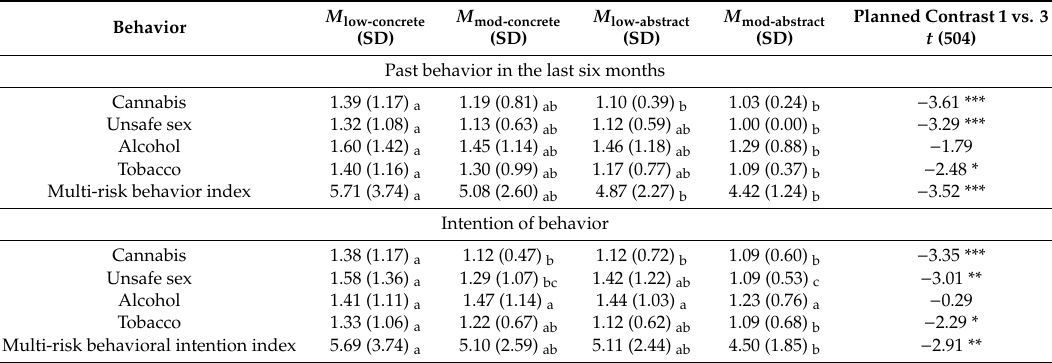
Table 5. Post-hoc comparisons between the four groups combining status and mindset in risk behaviors and intention of risk